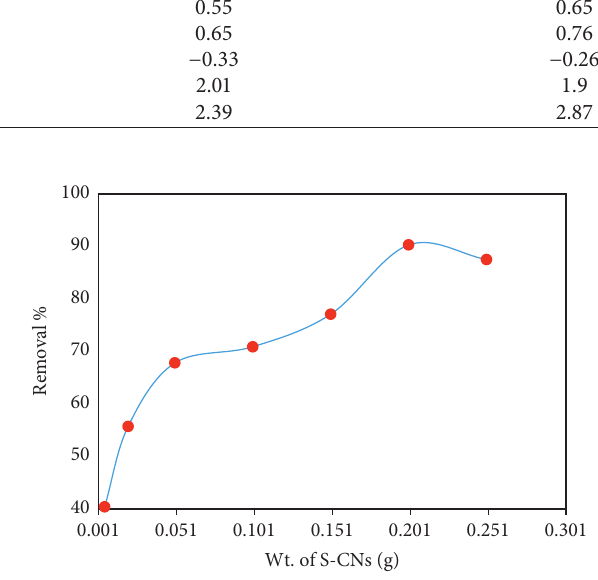
Figure 8: EffectofadsorbentdoseontheremovalpercentageofPb(II).